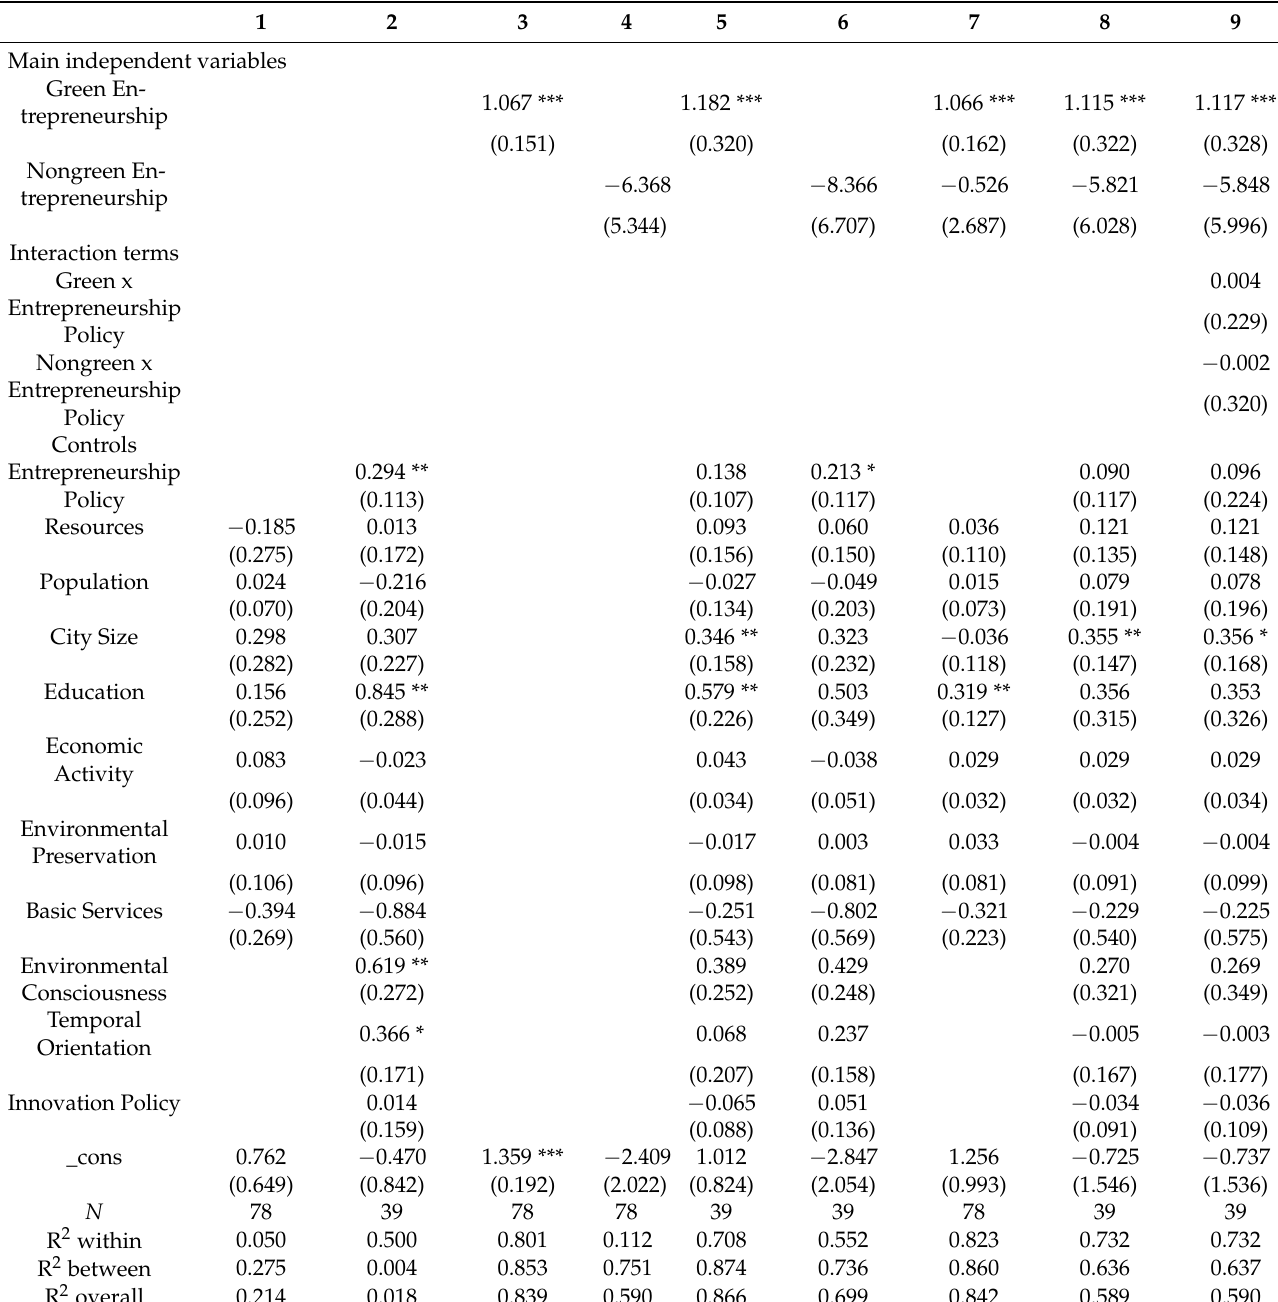
Table A5. Regression analysis (DV = environmental